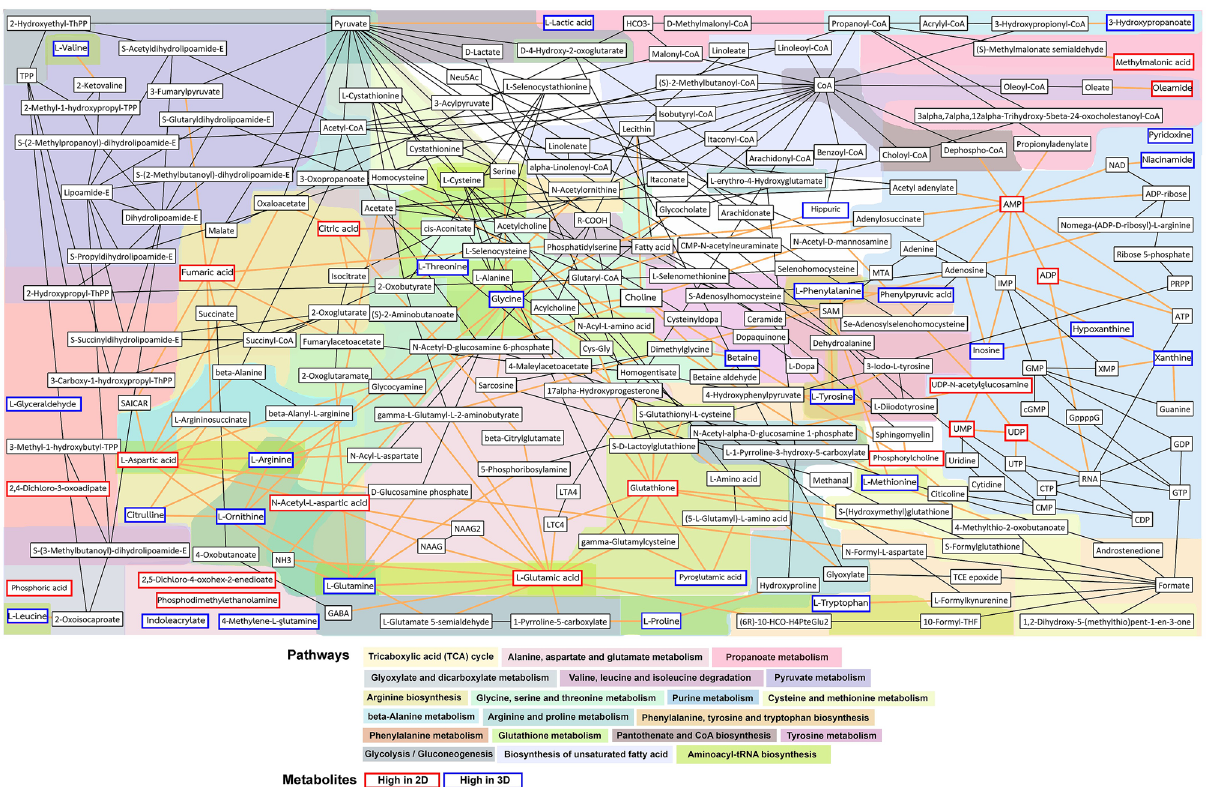
Figure 6. The impact of 2D and 3D culture systems on CCA and cholangiocyte cell lines metabolic reaction networks. Metabolic reaction networks of metabolites found in different 2D and 3D in CCA and cholangiocyte cell lines comparisons, using KEGG pathway-based 24–26 MetaboNetworks toolbox in MATLAB environment. The networks show metabolic reaction links between metabolites in each cell line. The red-line boxes indicate the metabolites found with higher concentrations in the 2D culture, while the blue-line boxes indicate those with higher concentrations in 3D MCS. The black-line boxes indicate metabolites in the metabolic backbone. The colored-background shading indicates different metabolic pathways. This metabolic map was generated using MATLAB R2015a (MathWorks, Inc., USA) equipped with MetaboNetwork toolbox 23 using our own data as input and the background shading was added to the graphs to indicate the different interconnecting pathways 27